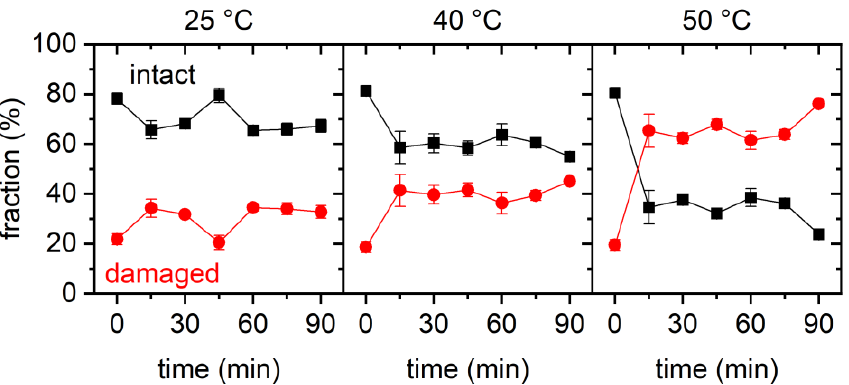
Figure 2. Results of the statistical analysis of the AFM images for 2 M GdmCl. Each data point represents the average of three AFM images with the standard deviations given as error bars.